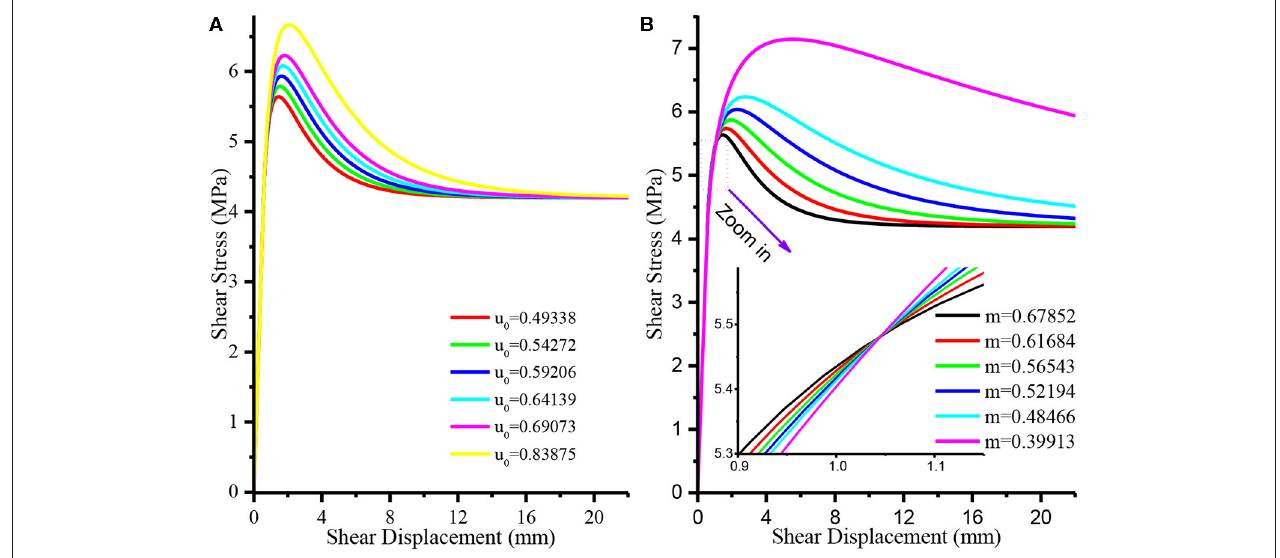
FIGURE 9 | The results for parametric studies of the proposed model for different values of Weibull distribution parameters. (A) Different u 0 , (B) different